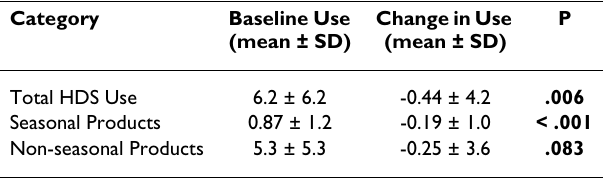
Table 3: Changes in Seasonal versus non-Seasonal HDS Table 2: Changes in the use among the most frequently used